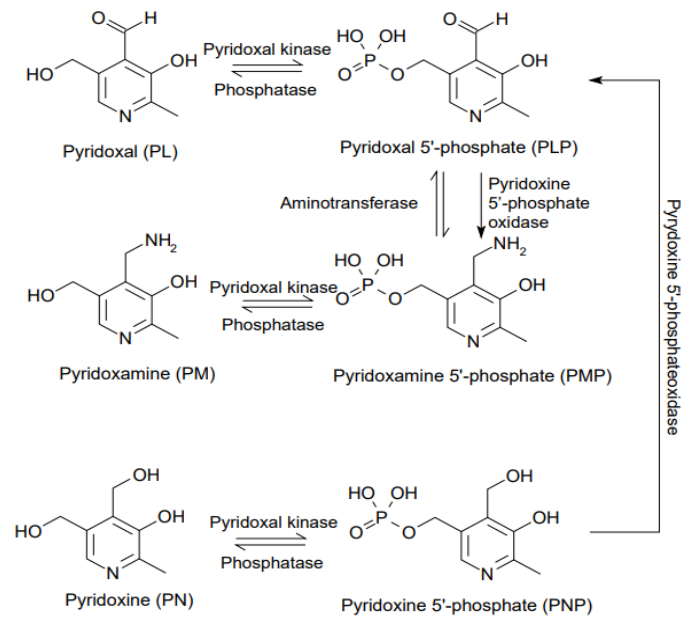
Figure 1. Forms of vitamin B6.